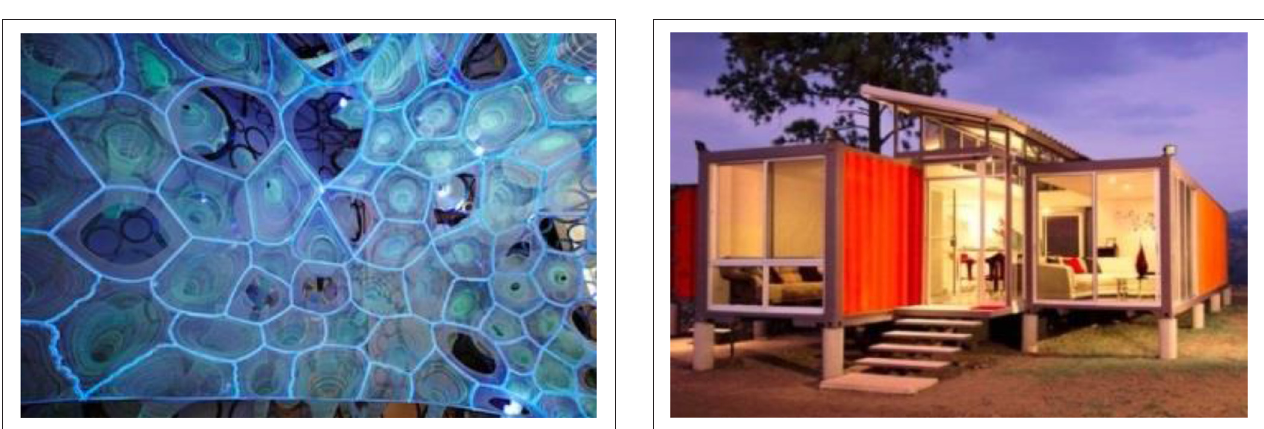
FIGURE 1 | An image used by an expert to explore modularity. FIGURE 2 | An image used by a crowd member to explore